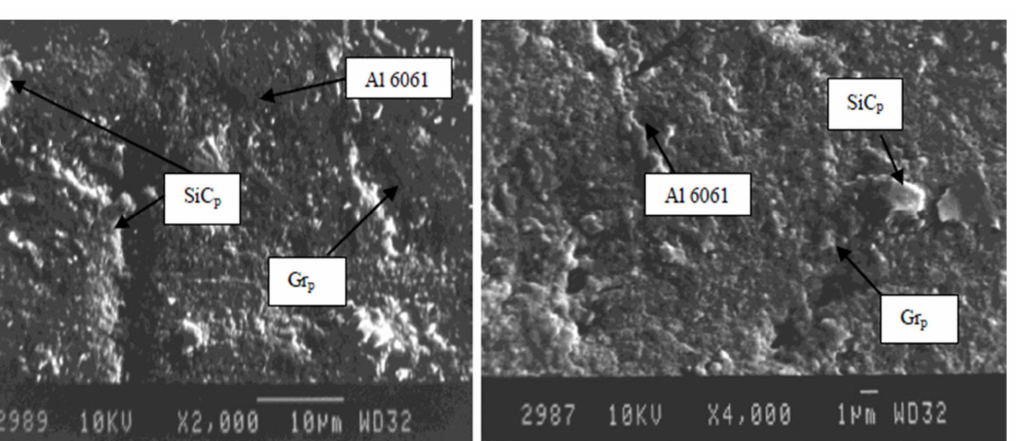
Figure 3. SEM images of Al6061/SiC/Gr before machining at different magnification